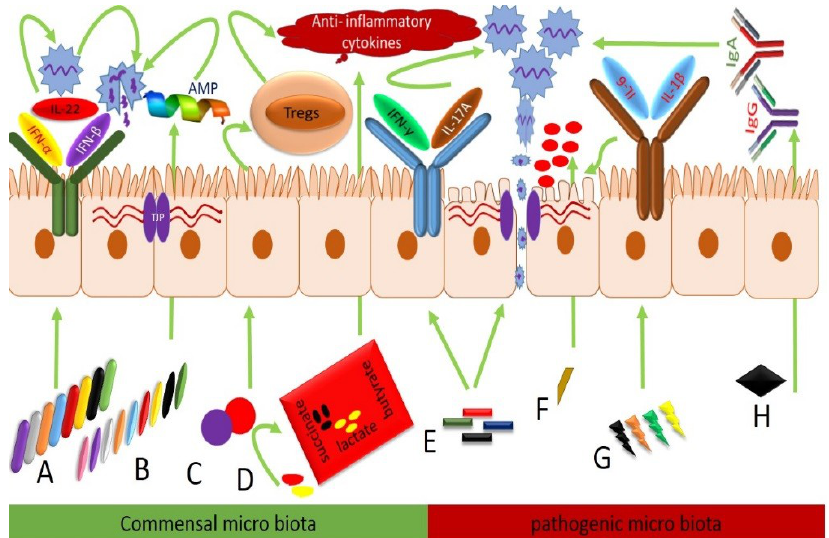
Figure 1. Regulation of different immune mechanisms by intestinal microbiota in AIV, IBDV, MDV, and NDV virus infected broiler chickens. (A) Collinsella , Faecalibacterium , Oscillibacter , Holdemanella, Pseudoflavonifractor , Anaerotruncus , Butyricoccus , and Bifidobacterium enhance the IFN-α, IFN-β, and IL-22 secretions, which control the virus replication by degrading the virus nucleus, as well as virus replication genes, and repair mucosal tissue damage. (B) Bacteroides , Candidatus , SMB53, Parabacteroides, Lactobacillus , Paenibacillus, Enterococcus , and Streptococcus spp. promote the antimicrobial peptides such as MUC, TFF, ZO, and tight junction proteins comprised of claudins, occludin, and zona occludens mRNA expressions and inhibit pathobiont colonization and translocation and suppress inflammation. (C) Clostridium XlVa and Firmicutes induce the T regulatory cells, which produce anti-inflammatory cytokines and suppress inflammation. (D) Faecalibacterium and Blautia spp. enhance butyrate succinate and lactate production, which provide energy and reduce inflammation. (E) Cluster XI, Salmonella, Escherichia , and Shigella are pathobionts. These pathogens decrease IFN-α, IFN-β, and IL-22 antimicrobial peptides such as MUC, TFF, ZO, and tight junction proteins comprised of claudins, occludin, and zona occludens mRNA expressions, increase the IFN-γ, IL-17A secretions that cause the mucosal inflammation, tissue damage Increased virus replication and fecal shedding. (F) Desulfovibrionaceae produce hydrogen sulfides and produce inflammation of mucosa. (G) Vampirovibrio , Clostridium cluster XIVb, and genus Ruminococcus induce the proinflammatory cytokines IL-6 and IL-1B, which produce GIT inflammation and leads to increased viral replication. (H) Salmonella typhimurium , Campylobacter jejuni decrease viral specific IgG and IgA production, which results in more viral shedding.